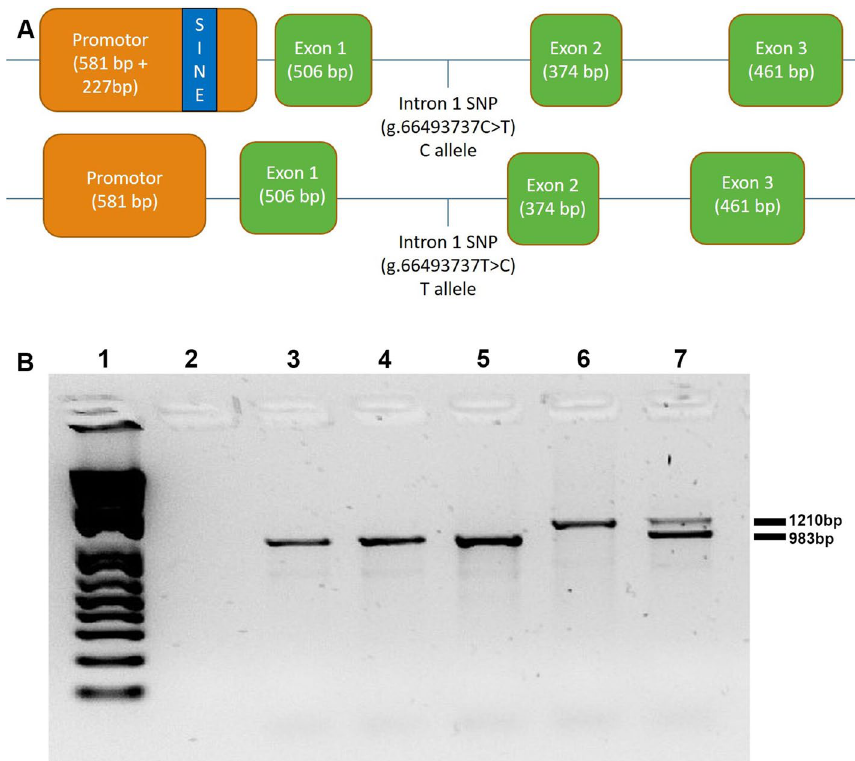
Figure 1. ( A ) Equine MSTN gene structure in Thoroughbred horses. (1) Note the presence of the SINE mutation within the promoter which is in linkage disequilibrium with an intronic SNP (C allele) in Thoroughbred racehorses. (2) In contrast, wild type horses that lack the SINE, have a T allele at the SNP. The equine MSTN gene consists of three coding exons (in green). ( B ) Genotyping agarose gel electrophoresis of PCR products designed to test for the presence or absence of the MSTN promoter SINE mutation. Lane 1 is a 1 kb DNA ladder followed by a water control (no band). DNA products in the following five lanes represent 3 Wild Type animals in lane 3, 4 and 5 (983 base pair (bp) product), one homozygote in lane 6 (1210 bp) and one heterozygote with both bands in lane 7 (983 bp and 1210